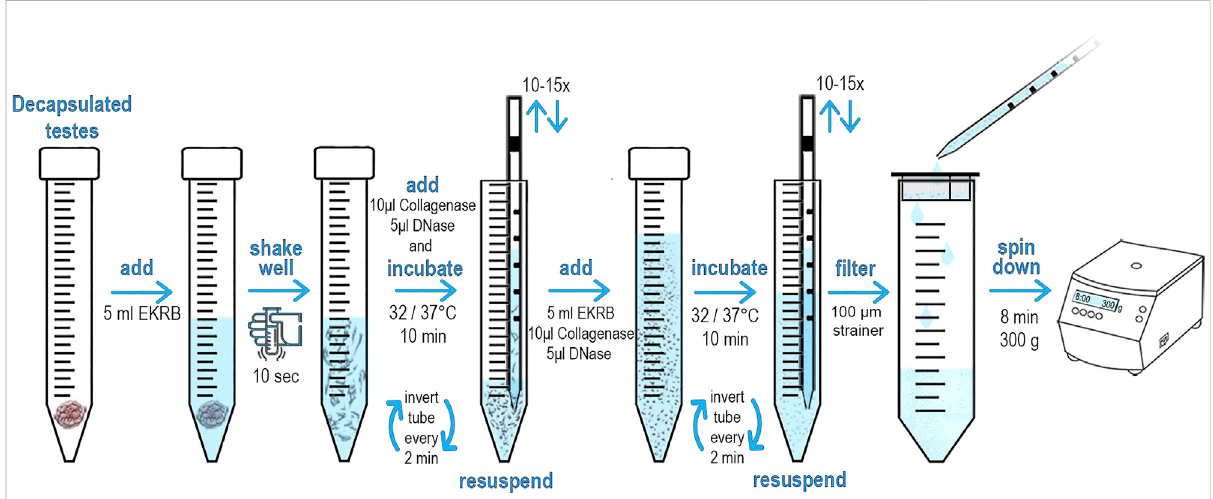
FIGURE 1 Schematic diagram and protocol of preparation of testicular single cell suspension. The male mouse was euthanized. An incision was them made under scrotum, testes were removed, dissected and transferred to a Petri dish. Using scissors, the tunica albuginea was opened to release the seminiferous tubules (STs). STs were immediately placed into 15 ml conical tube containing 5 ml of freshly made pre-warmed EKRB. The tissue was disrupted by vigorously shaking by hand for at least 10 s 10 μ L Collagenase (50 mg/ml) and 5 μ L of DNase (10.000U) was then immediately added and incubated at 32 ° C/37 ° C (according to age of the male) for 10 min. The samples were inverted every 2 minutes to keep the tubules in suspension. STs are then disrupted by slowly pipetting through serological pipet. Repeat 10 – 15 times until STs are fragmented. An additional 5 ml of EKRB, 10 μ L Collagenase (50 mg/ml) and 5 μ L of DNase (10.000U) is added and incubated for another 10 min at the desired temperature. The samples were inverted every 2 minutes to keep the tubules in suspension. The remaining ST fragments are disrupted by slowly pipetting through a serological pipet. Pipet up and down at least 10 – 15 times until the suspension appears opaque and the ST fragments are no longer visible. Transfer thecellsuspensiondropwisewithserologicalpipetintoanewconicaltubethatisequippedwithaninserted100 μ mstrainertoobtainaSTsinglecell suspension. Centrifuge the cell suspension for 8 min at 300 g to pellet the cells. Discard the supernatant and add 200 μ L of pre-warmed EKRB. Gently re-suspend pelleted cells by tapping on the tube bottom. Add the conjugated antibody and incubate at 32 ° C/37 ° C in a dark